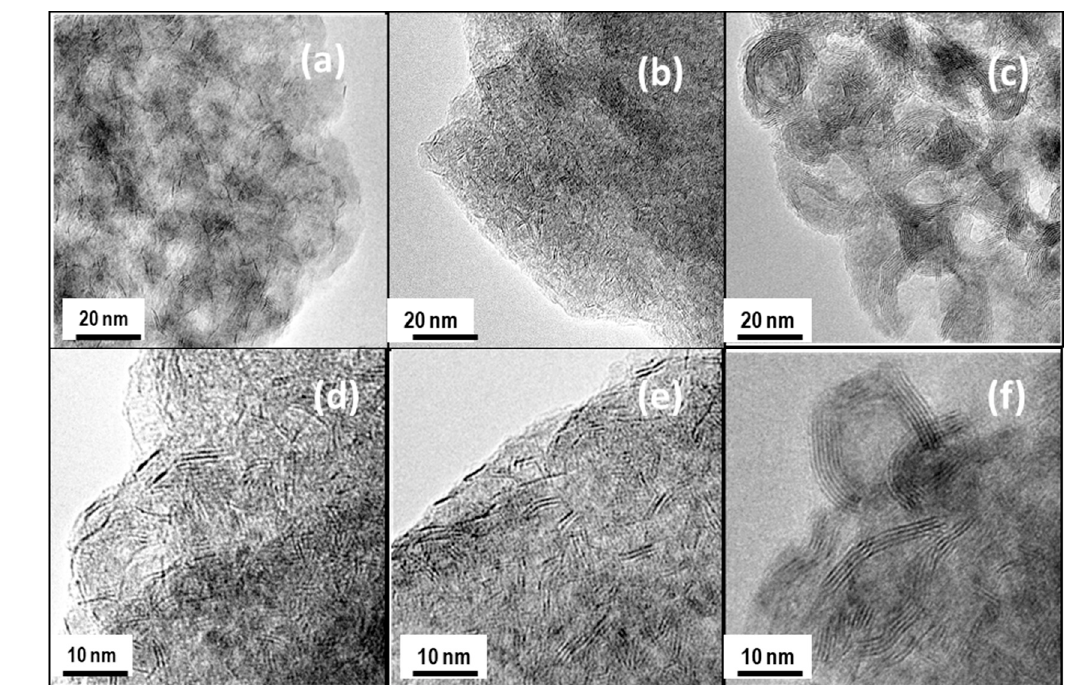
Figure 10. TEM images of used catalysts taken at different scales: NiMoW/Al ( a , d ), NiMoW/Al-Ce10 ( b , e ), and NiMoW/Al-Ce15 ( c , f ).